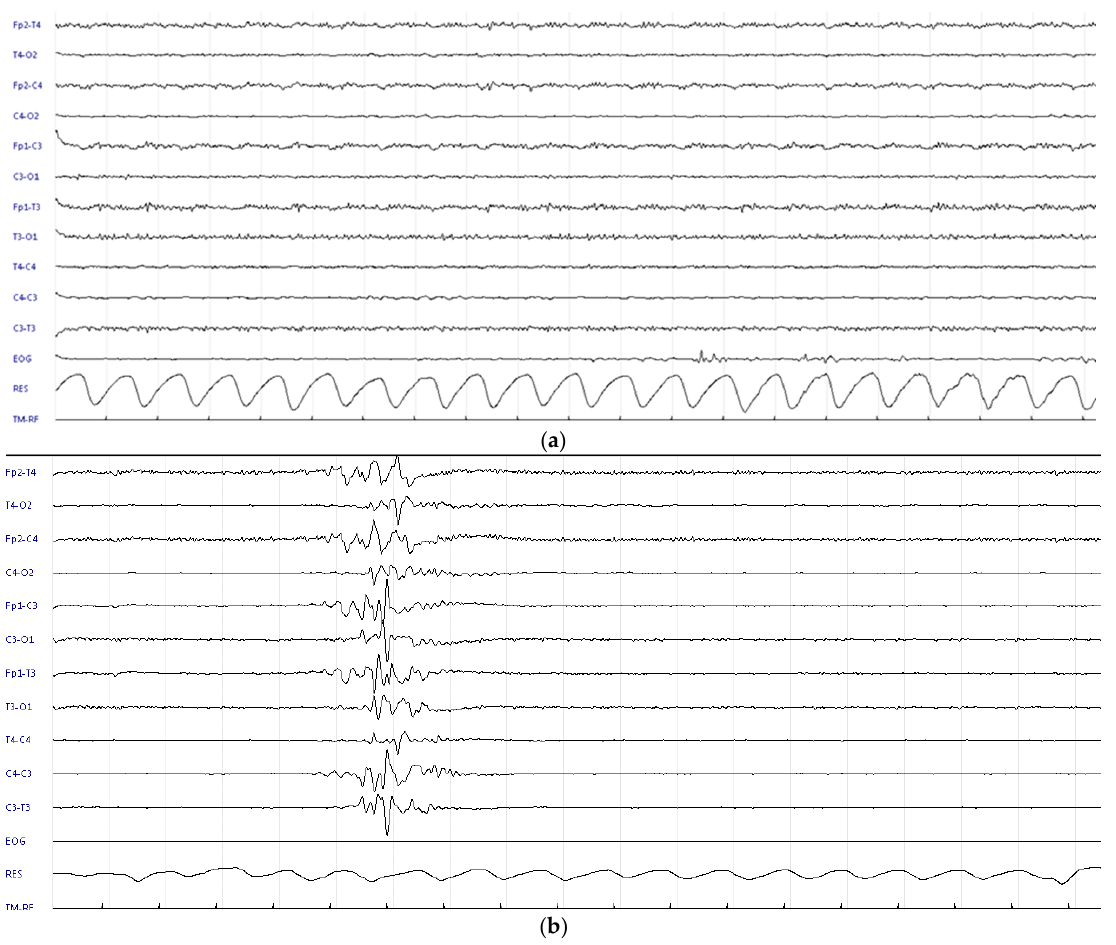
Figure 1. p-EEG in case 1 ( a ) at recruitment: severe p-EEG depression with superimposed muscular activity; ( b ) at 24 h during TH: burst suppression pattern with long inter-burst periods.